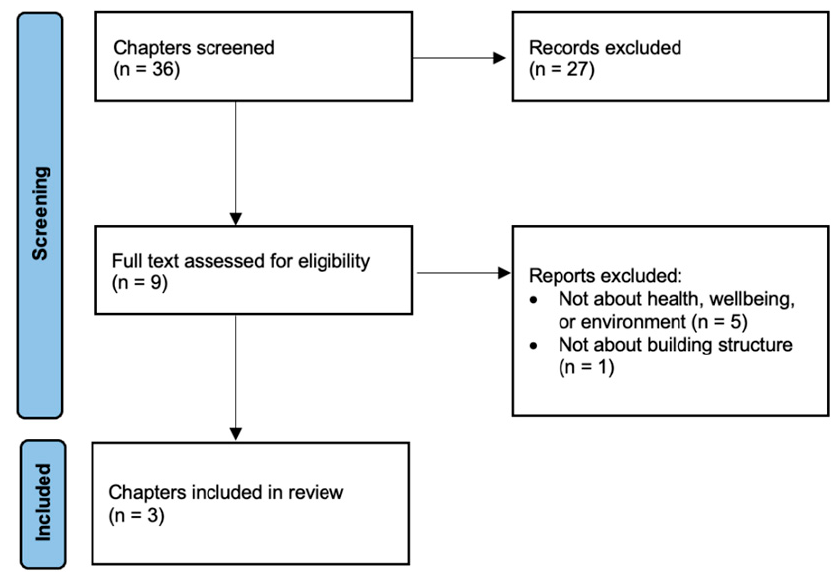
Figure 2. Flow diagram of the book-chapter-selection process.